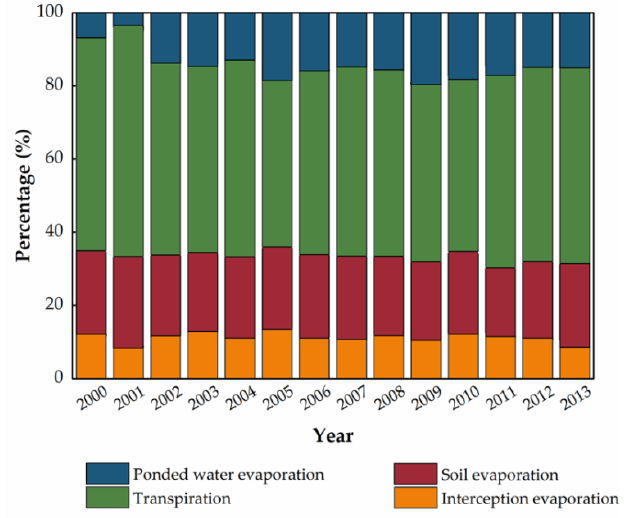
Figure 5. Trend of annual watershed-level reference evapotranspiration (ET o ), evapotranspiration (ET), and its partitioning in the Qinhuai River Basin from 2000 to 2013.